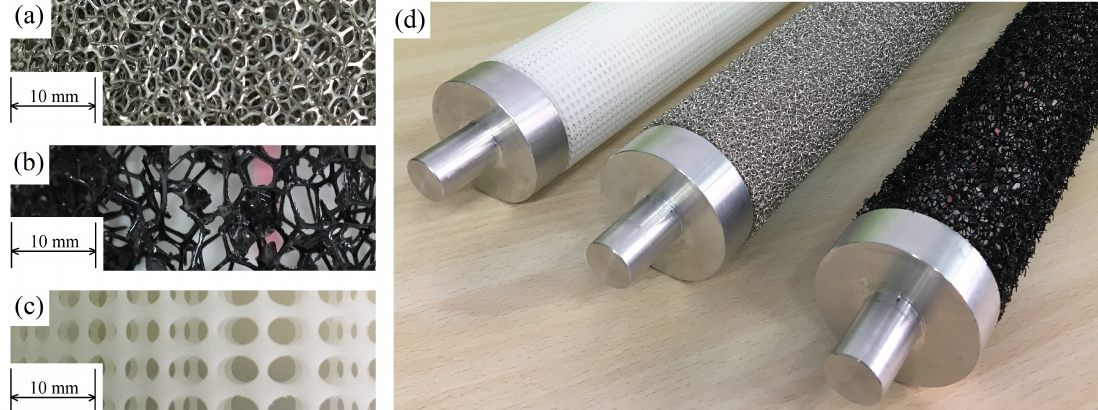
Figure 2. Photos of the PCC materials used in this study, applied to a cylindrical body. ( a ) Nickel-metal foam obtained from Kunshan Tengerhui Electronic Technology Co., Ltd., ( b ) Porous polyurethane obtained from Shenzhen Shiyuan Foam Co., Ltd. and ( c ) Structured porous coating manufactured via 3-D printing. Image ( d ) shows the three PCCs with their wind tunnel fittings attached. All materials were manufactured in Shenzhen,